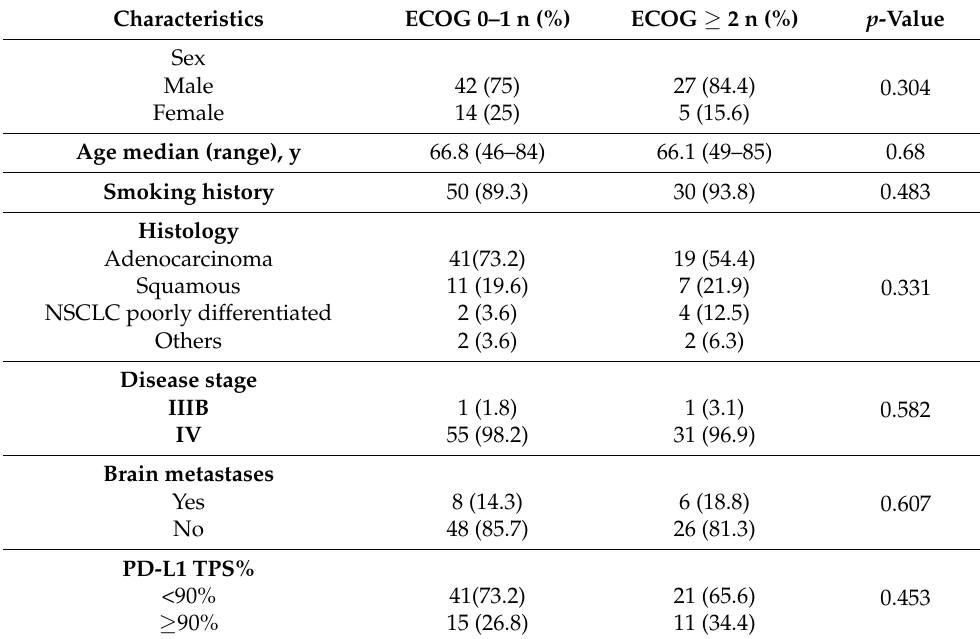
Table 2. Baseline demographic and clinical characteristics of patients according to ECOG